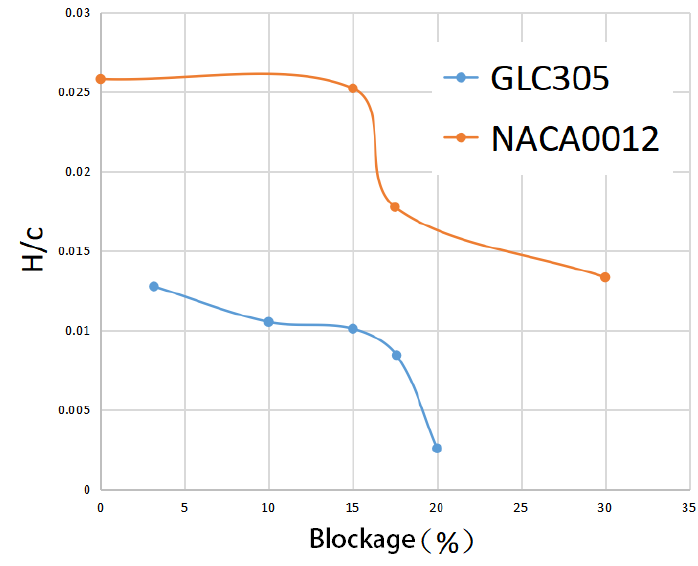
Figure 9. Relationship between the blockage and the dimensionless projection height.